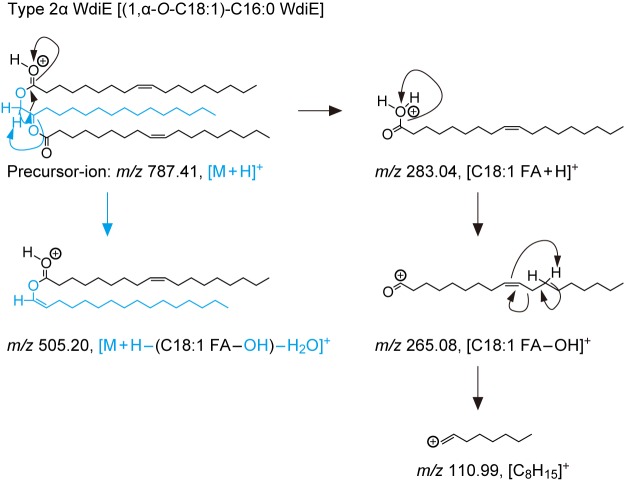
Predicted fragments from type 2α WdiE.